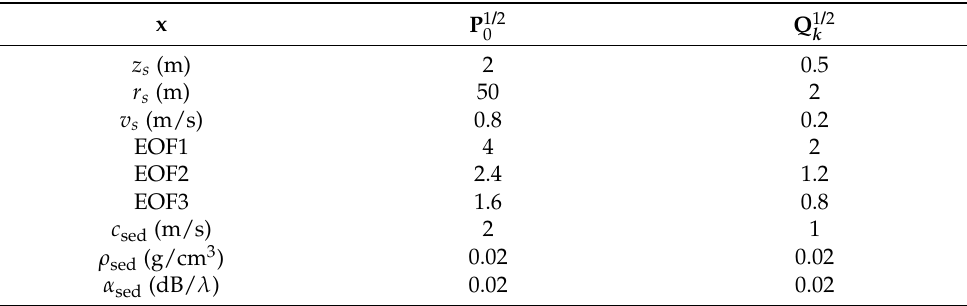
Table 4. ASIAEX: improved-PF